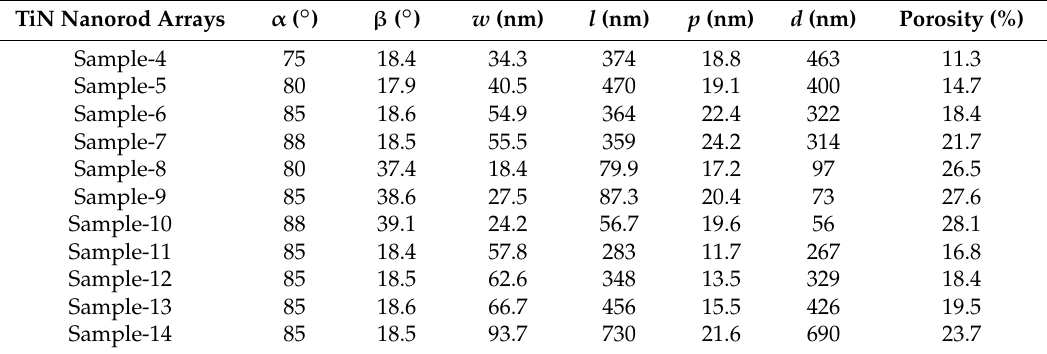
Figure 6. Top-view and cross-section scanning electron microscopic (SEM) images of TiN NRAs deposited at α = 85° with length of rod l equal to ( a ) 283 nm, ( b ) 348 nm, ( c ) 456 nm, and ( d ) 730 nm. Table 1. Average deposition angle ( α ), tilt angle ( β ), rod width ( w ), length of rod ( l ), spacing between adjacent rods ( p ), porosity, and thicknesses ( d ) of titanium nitride (TiN) nanorod arrays (NRAs).